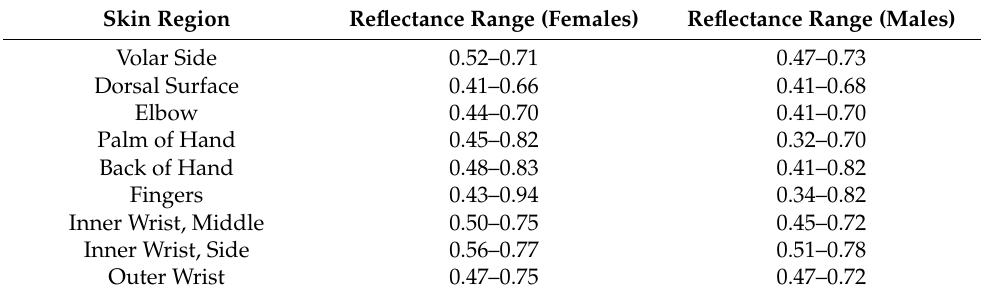
Table 1. Reflectance range for a sample of 60 healthy participants.